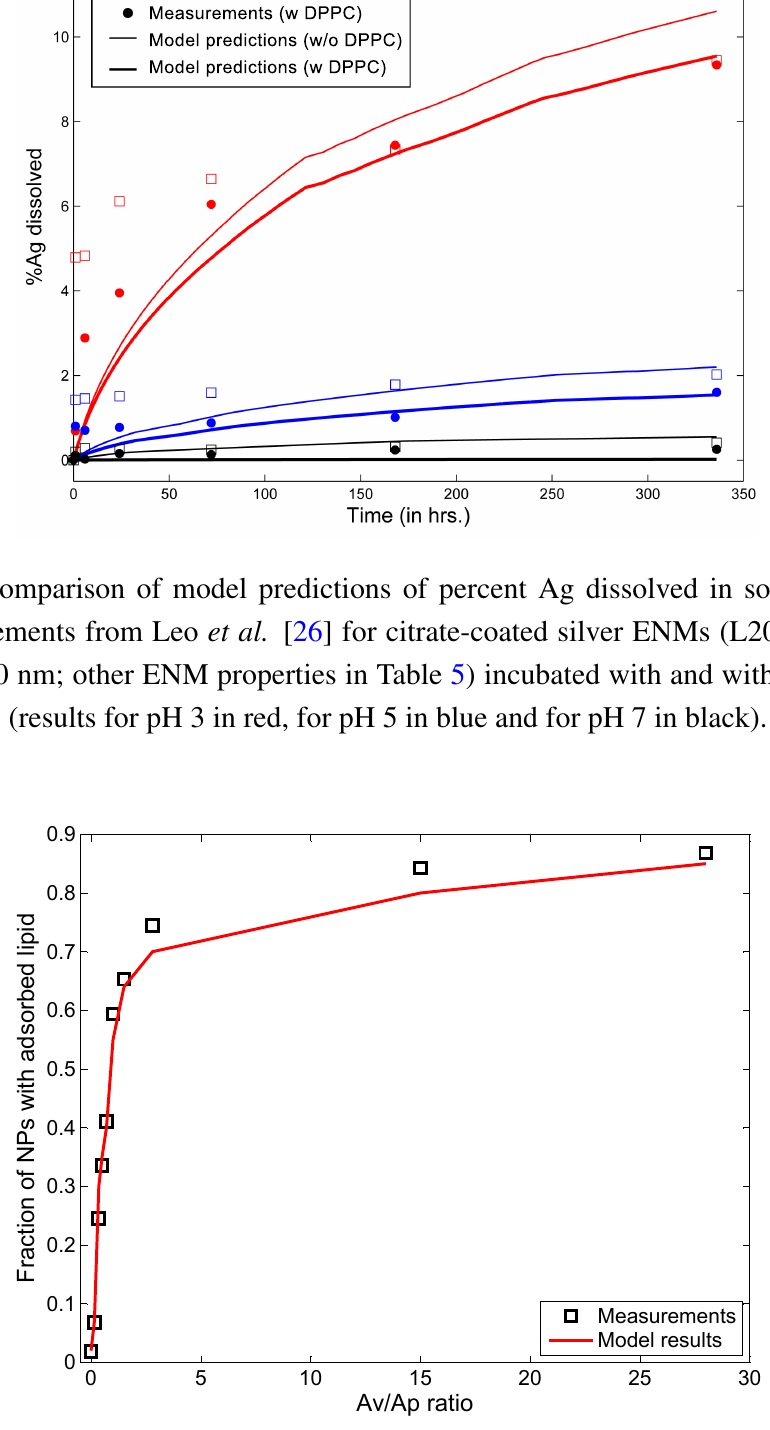
Figure 4. Comparison of model predictions (red line) of fraction of NPs (N600; initial mean diameter = 600 nm; other ENM properties in Table 5) with adsorbed lipids after 1 h of incubation, with in vitro measurements (black squares) from Nordlund et al. [39] for different values of surface area ratios of lipid vesicle to